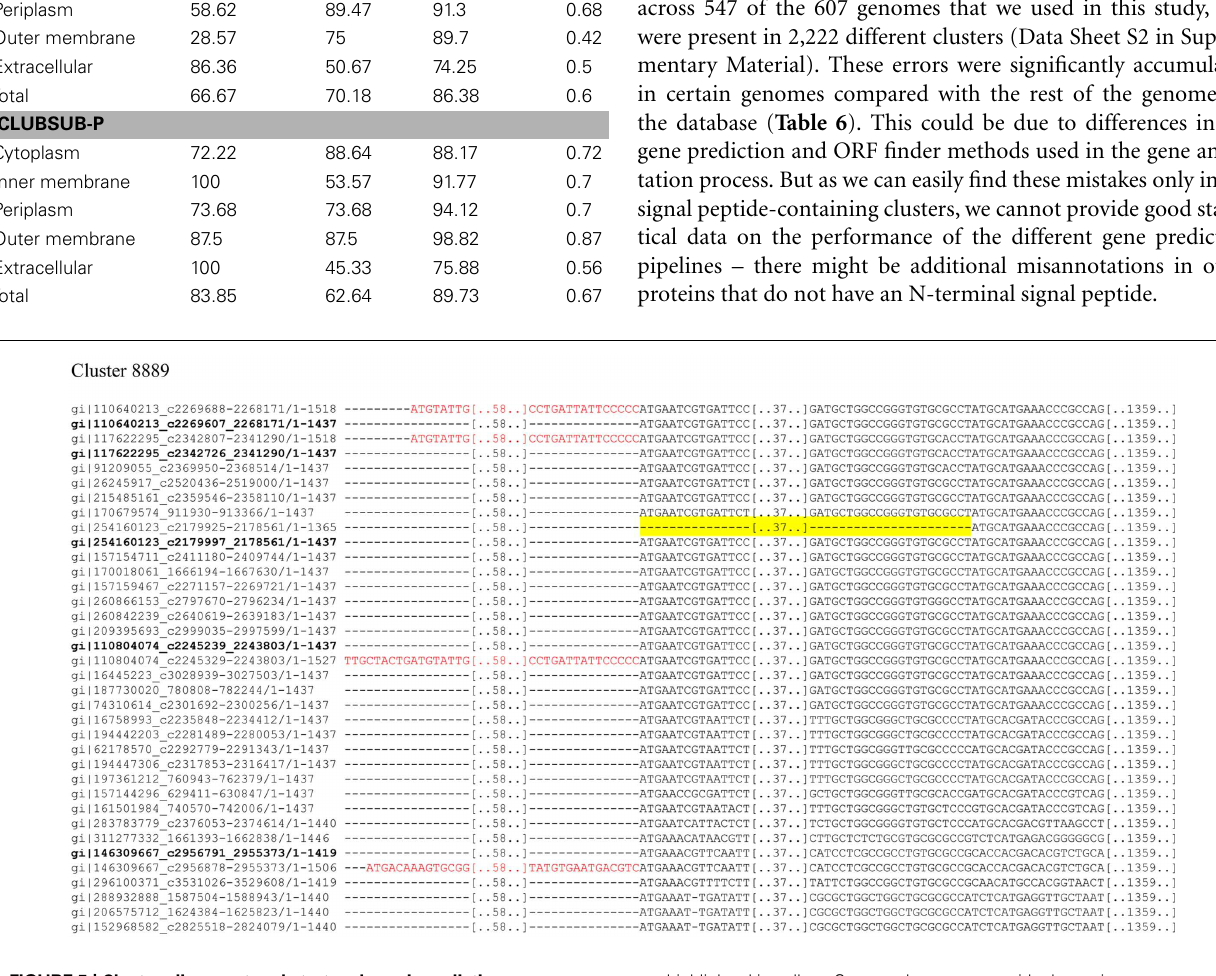
are highlighted in yellow. Corrected sequences with alternative start codons are shown in bold.These corrections in most cases lead to corrected predictions of signal peptides. For clearer view, sequences are